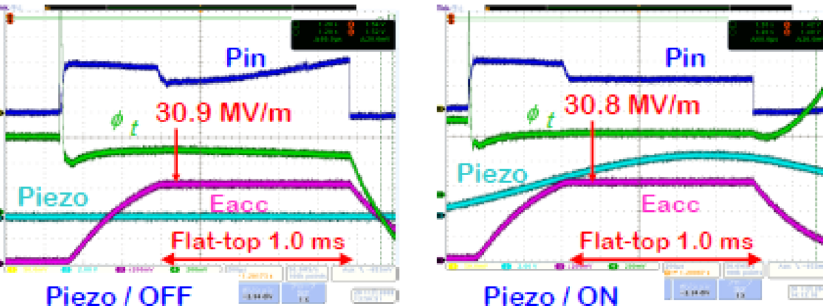
FIG. 23. (Color) Pulsed signals at high field operation in C/#2 cavity without piezo drive voltage (left) and with piezo drive voltage (right). The light blue line is the piezo drive voltage. The green line is the cavity phase ( (cid:2) t ) between the transmitted rf power through a cavity and a reference. The dark blue line is the input rf power, and the purple line is the accelerating gradient. The accelerating gradient (pink line) and cavity phase (green line) were kept constant by an rf feedback control. The obtained amplitude and phase stabilities were 0.01% rms and 0.02 deg rms by the rf feedback control system [10].